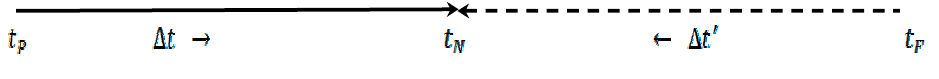
← → j , k and k (cid:48) , j (cid:48) .